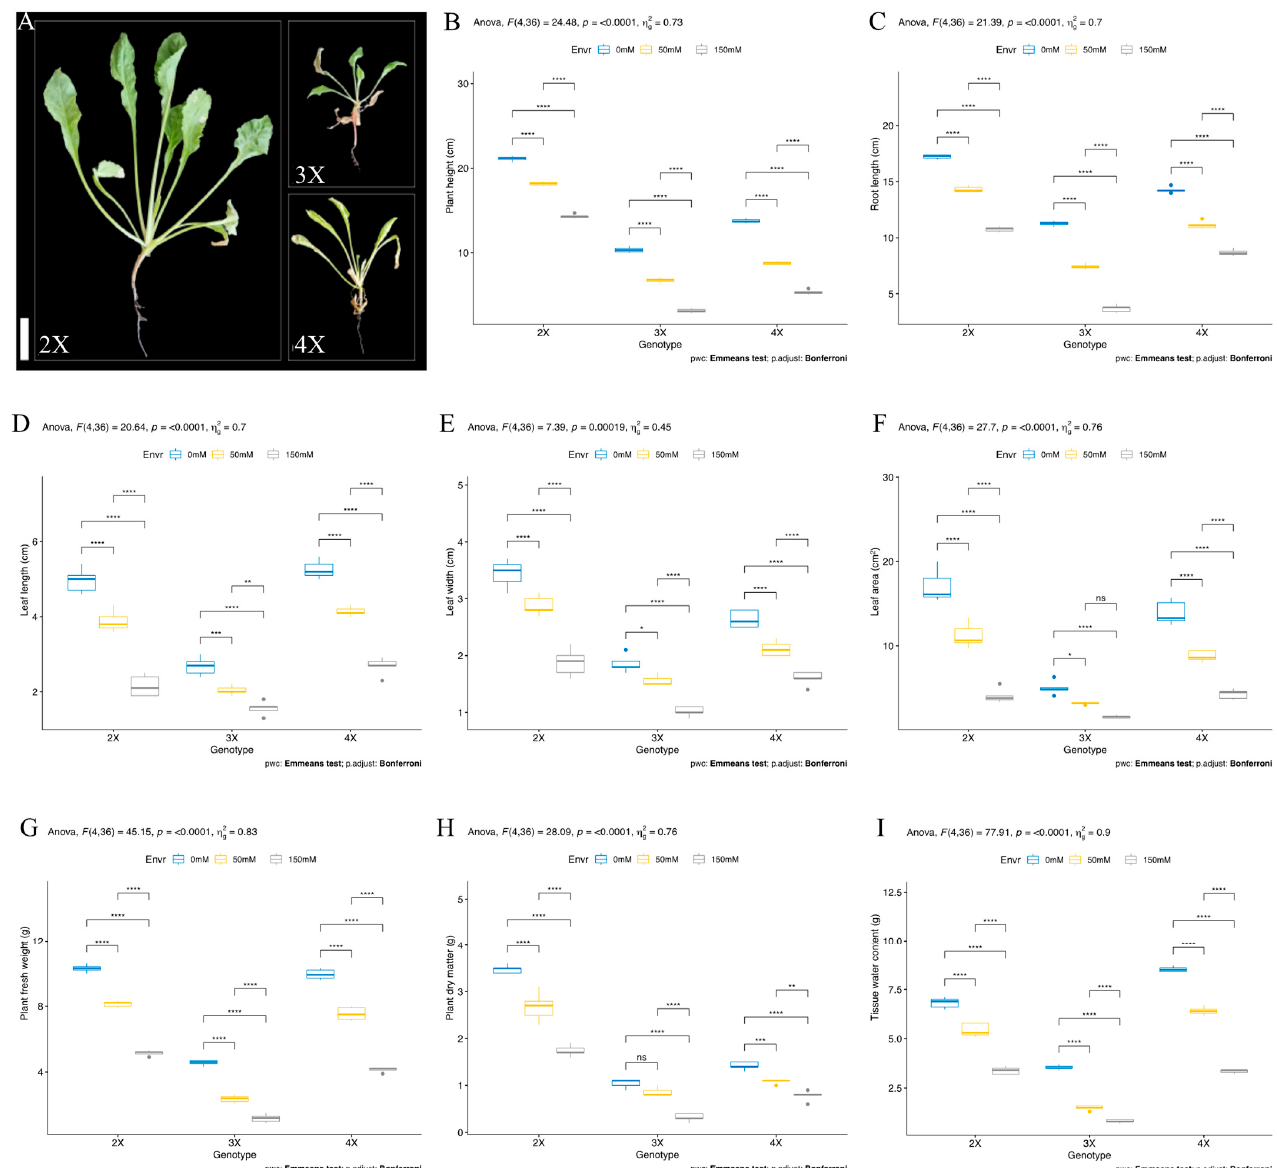
Figure 2. Effects of salinity stress on growth performance of different ploidy level sugar beet plants ( Beta vulgaris L.) at vegetative stage. ( A ) The general morphology of CVs. “Felicita” (2X), “Kassandra” (3X), and “AD-440” (4X) at 150 mM NaCl dose. Bar = 1.0 cm, ( B ) plant height, ( C ) root length, ( D ) leaf length, ( E ) leaf width, ( F ) leaf area, ( G ) plant fresh weight, ( H ) plant dry matter, and ( I ) tissue water content were measured in 42-day-old plants that were exposed to salt stress from germination. Means ( ± standard deviation) within the same graph followed by the Emmeans test and p -value adjusted by the Bonferroni method from five independent biological replicates ( n = 5). Asterisk indicates